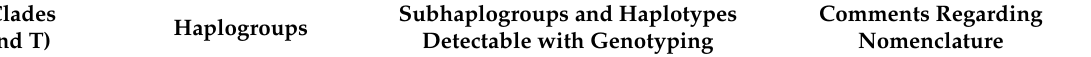
Table A3. Explanation of HG/HT nomenclature. HG/HT-determining variants are provided in Figure 2 and Table